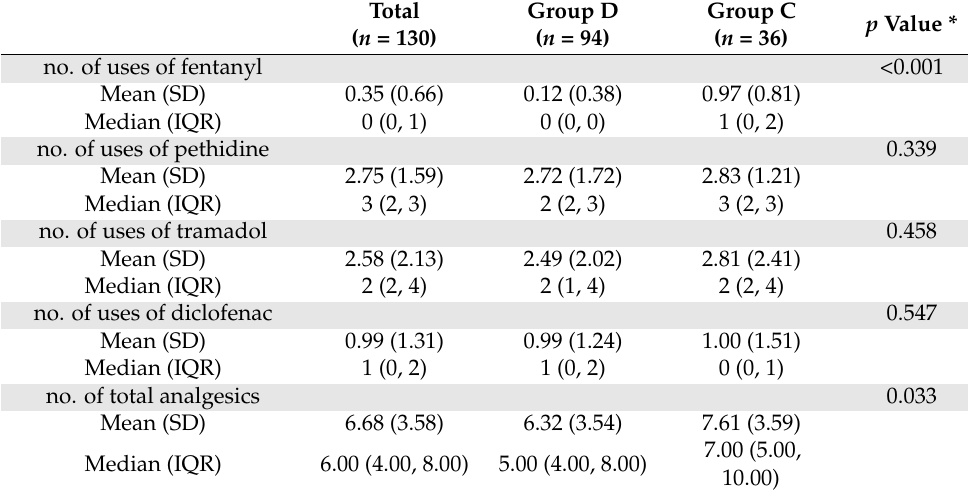
Table 3. Comparison of the number of postoperative analgesic uses between the two groups.